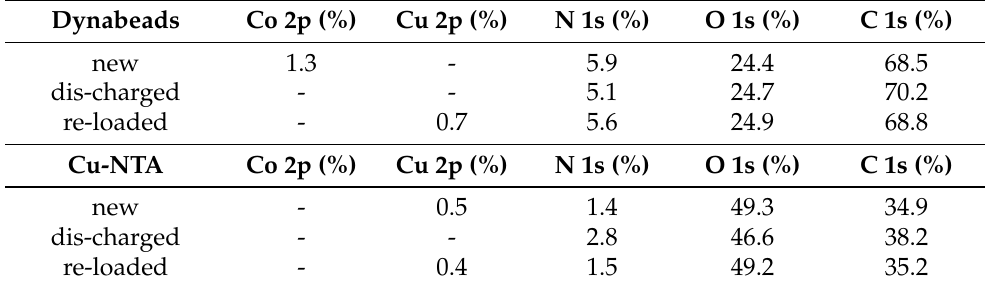
Table 1. XPS analysis at 90° take-off angle of the two types of beads with different treatments. The standard error does not exceed the 1–2% of the reported